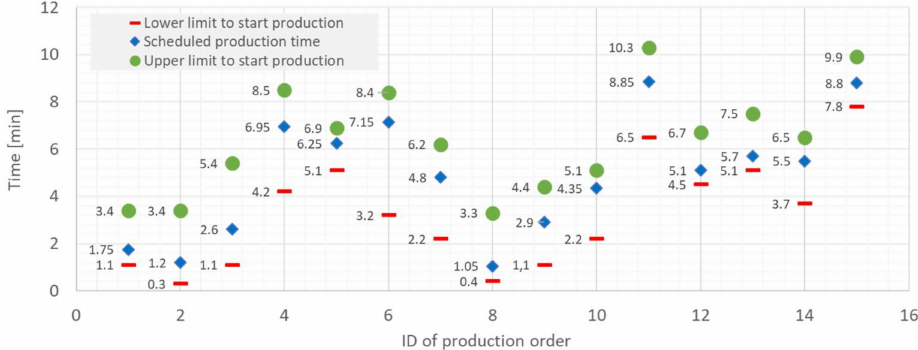
Figure 8. The distribution of scheduled production order between the related lower and upper time